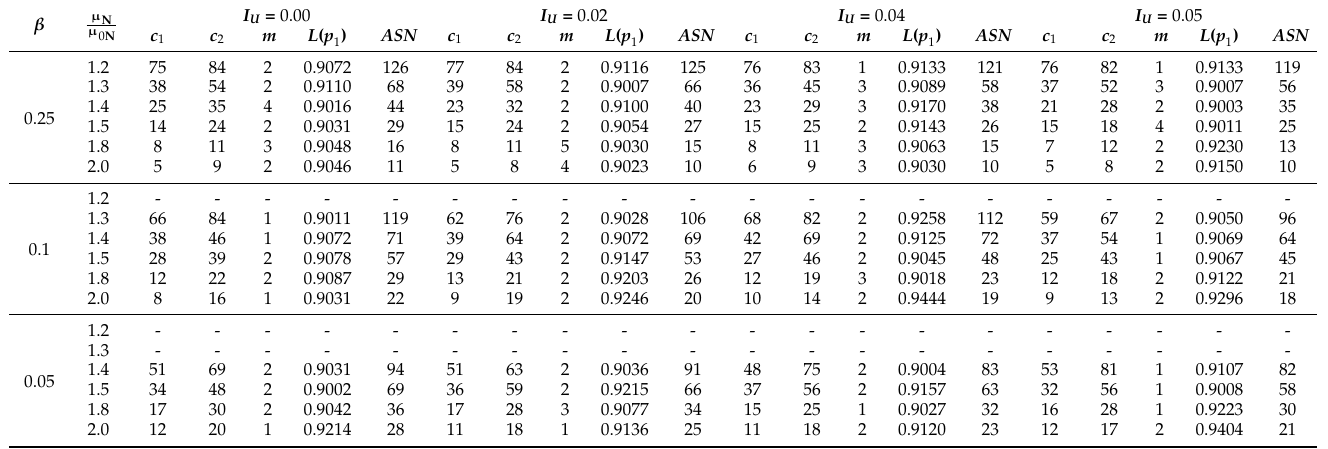
Table 8. The MDS design values for α = 0.10, ν = 1, and a =